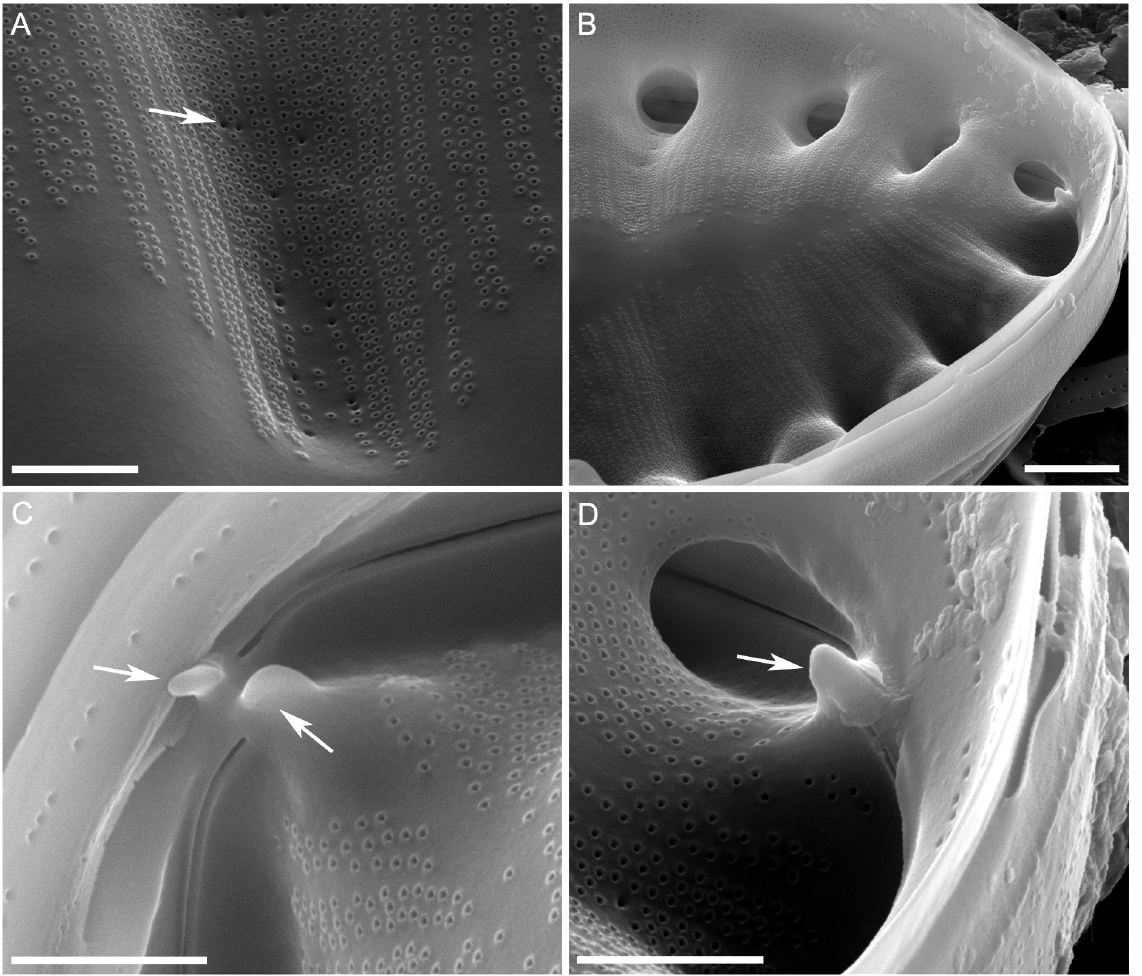
Fig. 5. Surirella ebalensis sp. nov., type material from sample CCA 2070, Lomami River, DR Congo, SEM. Internal view. A . Detail of the multiseriate striae, and the perforation of the elongated granules without rimmed margin (arrow). B, D . Detail of the continuous raphe near the apical pole with a reduced helictoglossa (arrow). C . Detail of the straight not expanded raphe endings at the foot pole and their reduced helictoglossae (arrows). Scale bars: B = 2 µm; A, C–D = 1